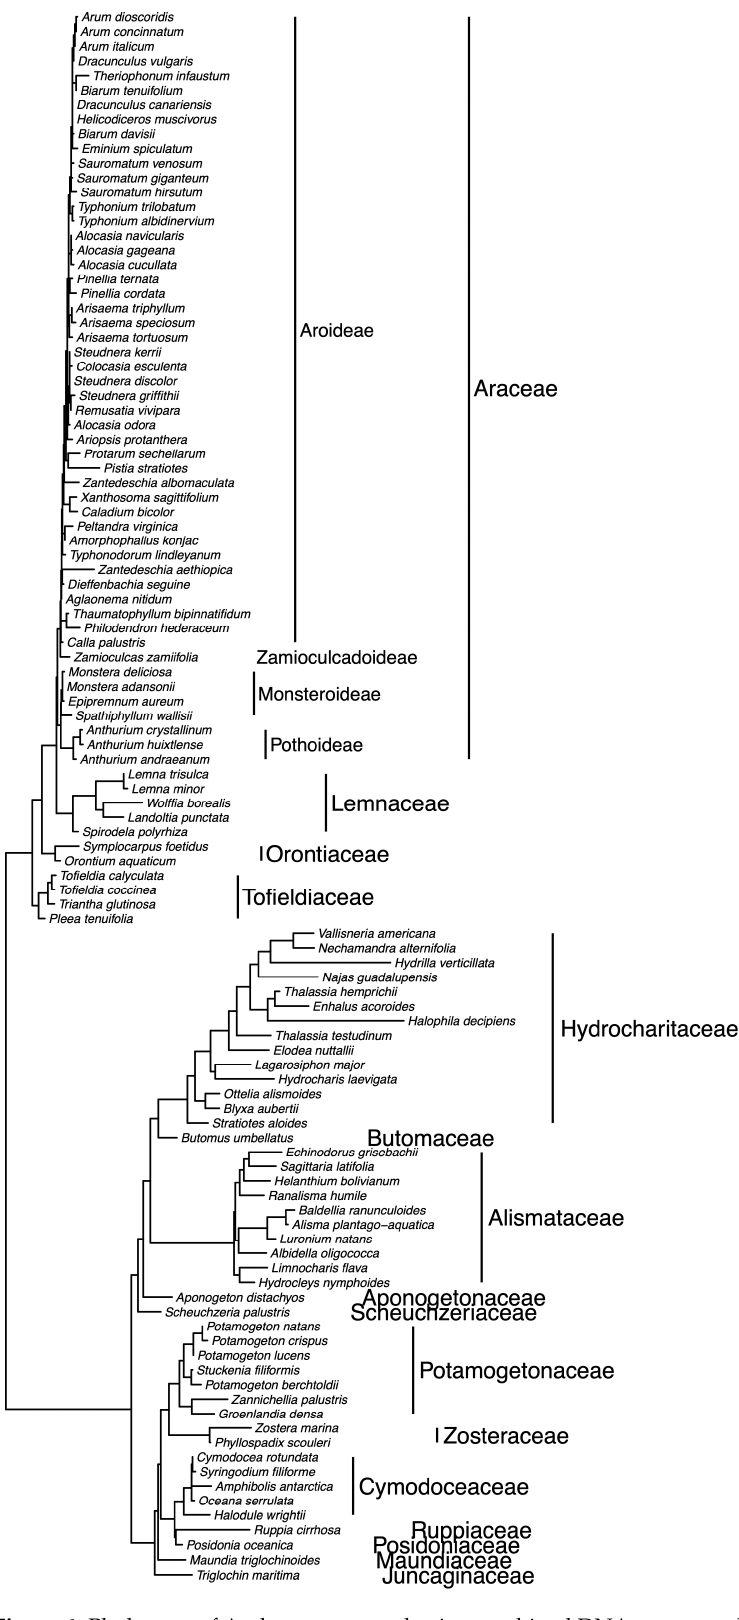
Figure 6. Phylogeny of Arales, constructed using combined DNA sequence data from four mitochon- drial regions ( atp1 , matR , rps3 , and nad5 ). The tree represents a maximum likelihood tree, constructed in IQ-TREE [18] using default